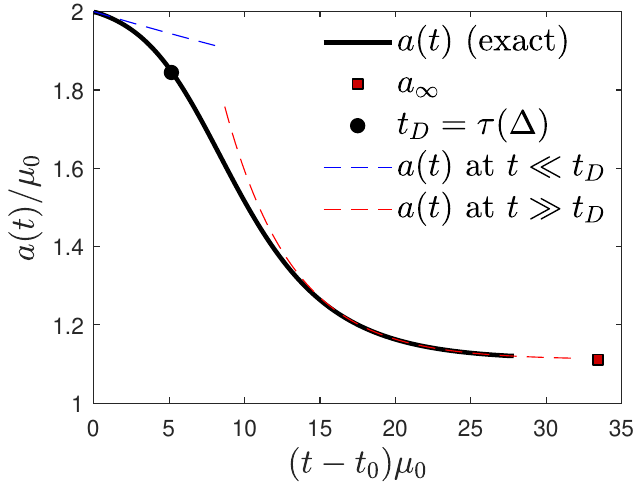
Figure 11. Infection rate, a ( t ) , versus real time t (solid black line) for the parameters used in Figure 10. The dot indicates the value at the transition time, t D (30), the red square shows a ∞ = µ 0 / k 1 at t → ∞ , while the asymptotic expressions (36) and (41) for small and large times, respectively, are shown by dashed lines of different colors as